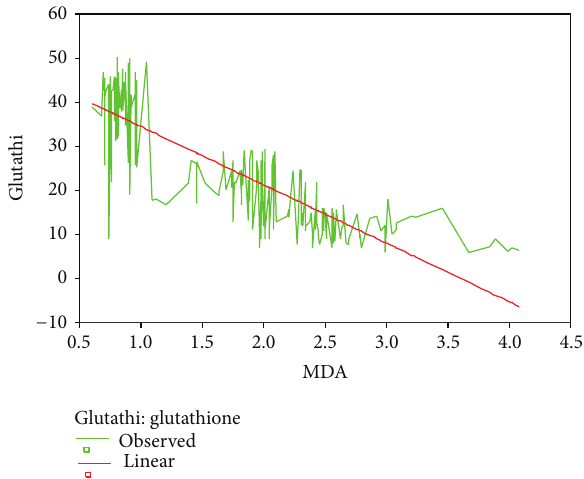
Figure 4: Correlation between GPX and Serum MDA in protein energy malnutrition ( 𝑃 < 0.001 ).